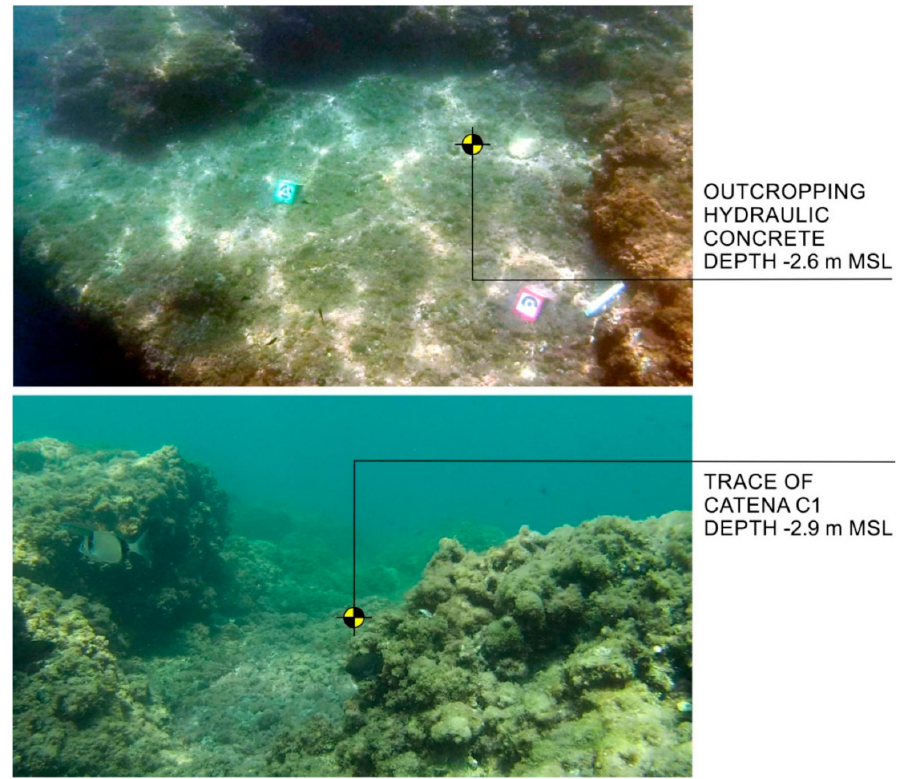
Figure 22. Underwater photo taken during the direct